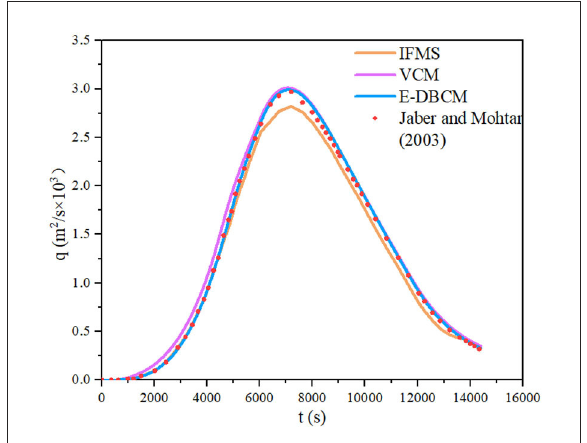
FIGURE7 The hydrographs obtained from different models.